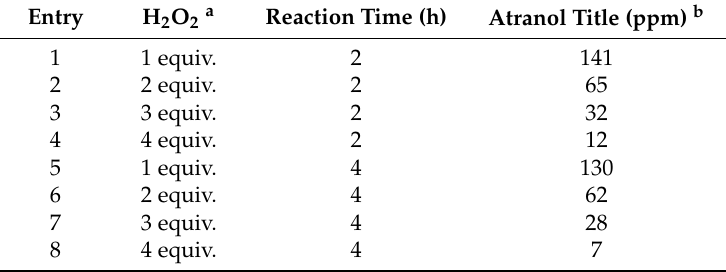
Table 4. Testing of reaction conditions for the HRP-based treatment of oakmoss absolute. Entry H 2 O 2 a Reaction Time (h) Atranol Title (ppm) b 1 1